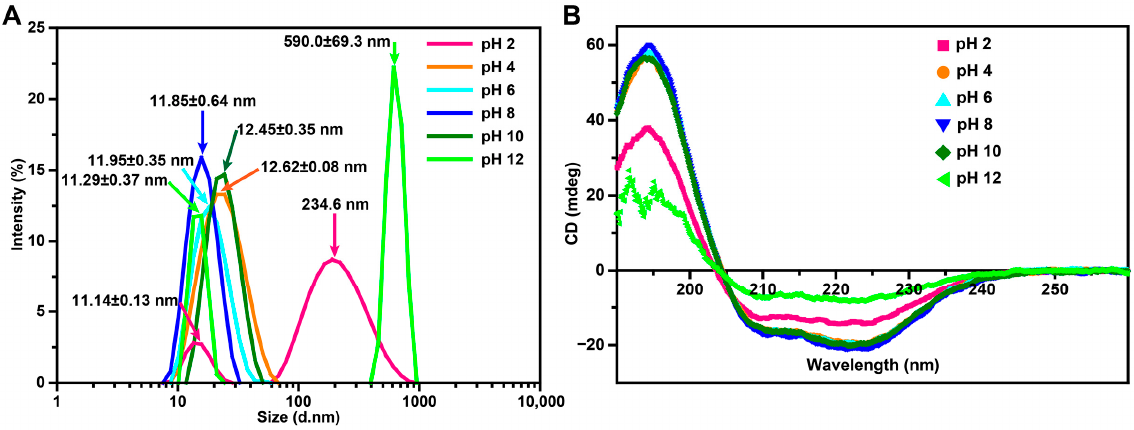
Figure 3. ( A ) DLS analysis of DzFer at pHs 2–12. ( B ) Effects of pH treatment (pH 2–12) on the sec- ondary structures of DzFer. secondary structures of